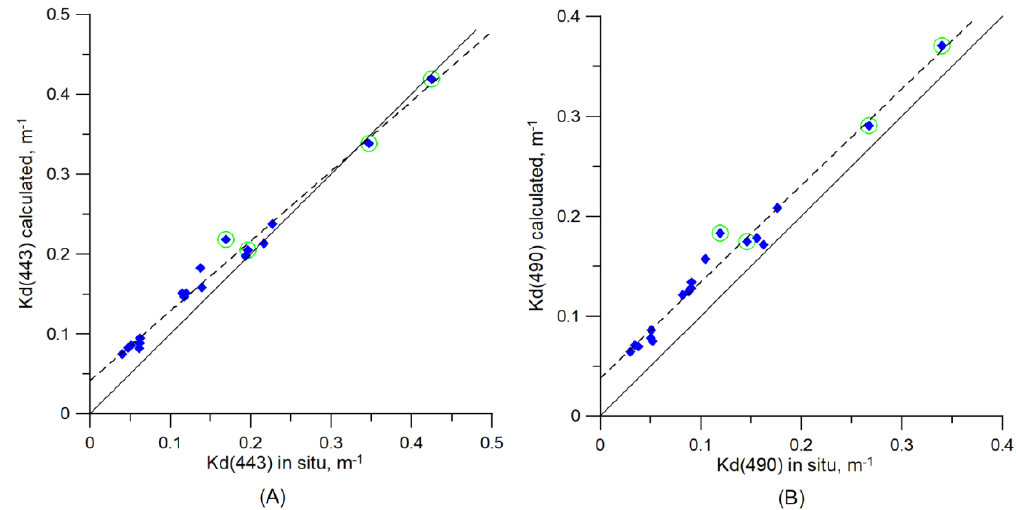
Figure 15. Scatterplot of the diffuse attenuation coefficient K d for the wavelengths 443 ( A ) and 490 ( B ) nm calculated by formula [52], and from in situ measurements of underwater irradiance at 18 stations in the Barents Sea (AMK 68). Solid black line—perfect correspondence 1:1; dotted black line—linear regression. Green circles show the stations with coccolithophore blooms.